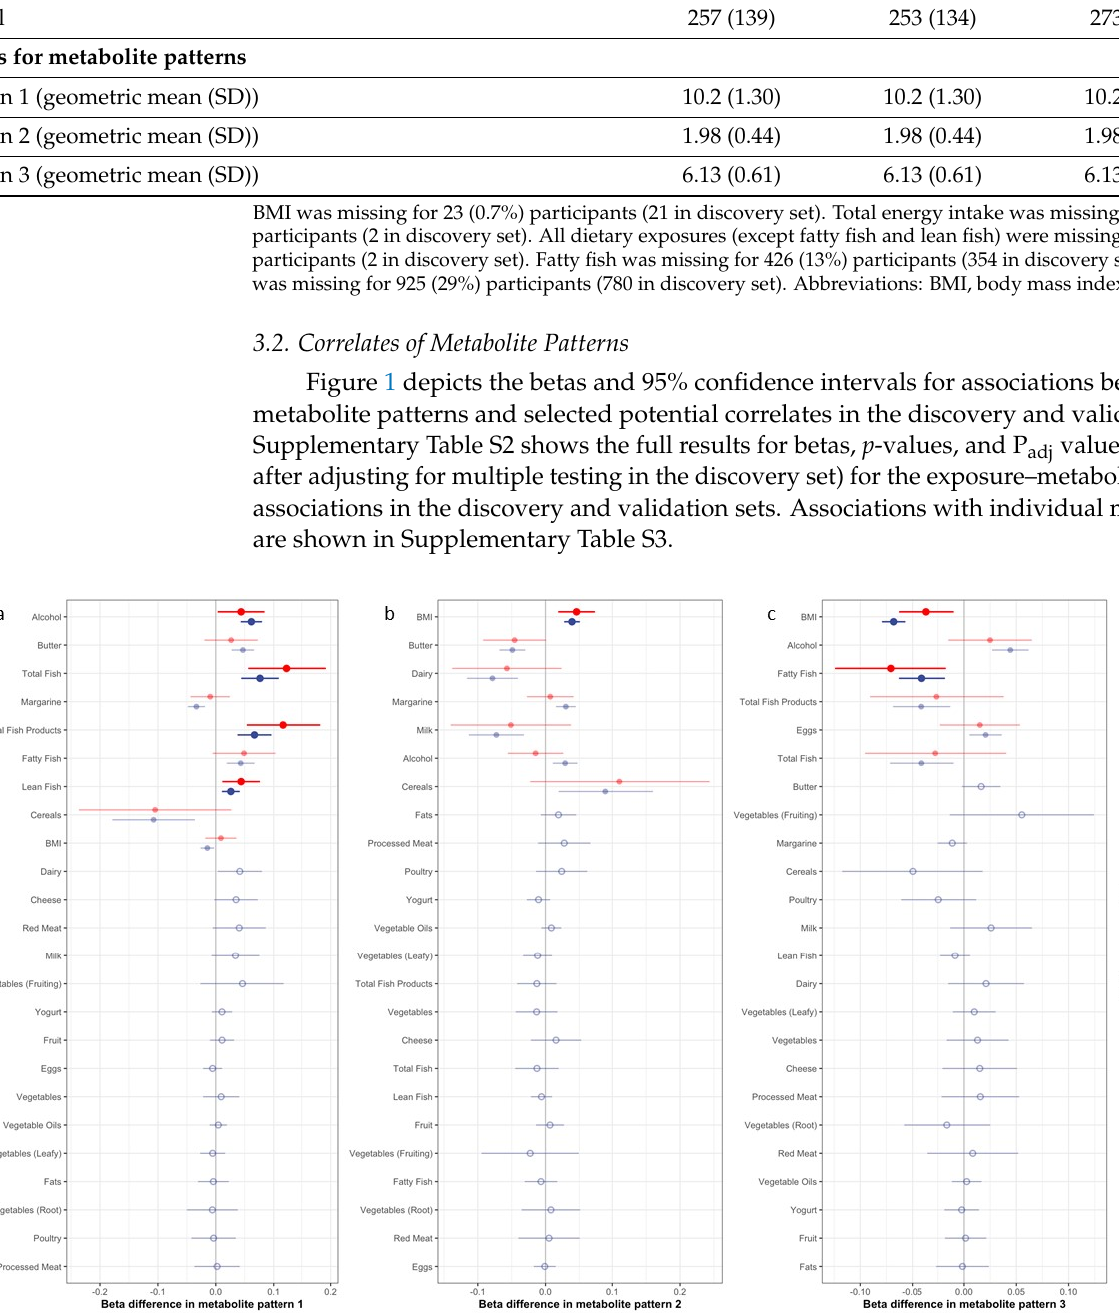
Figure 1 . Association of dietary and lifestyle factors with metabolite pattern 1 ( a ), pattern 2 ( b ), and pattern 3 ( c ). Estimates presented in bold are for dietary and lifestyle factors with both significant P adj associations in the discovery dataset (blue) and p < 0.05 in the validation dataset (red). Estimates with associations that do not pass FDR threshold are presented with hollow